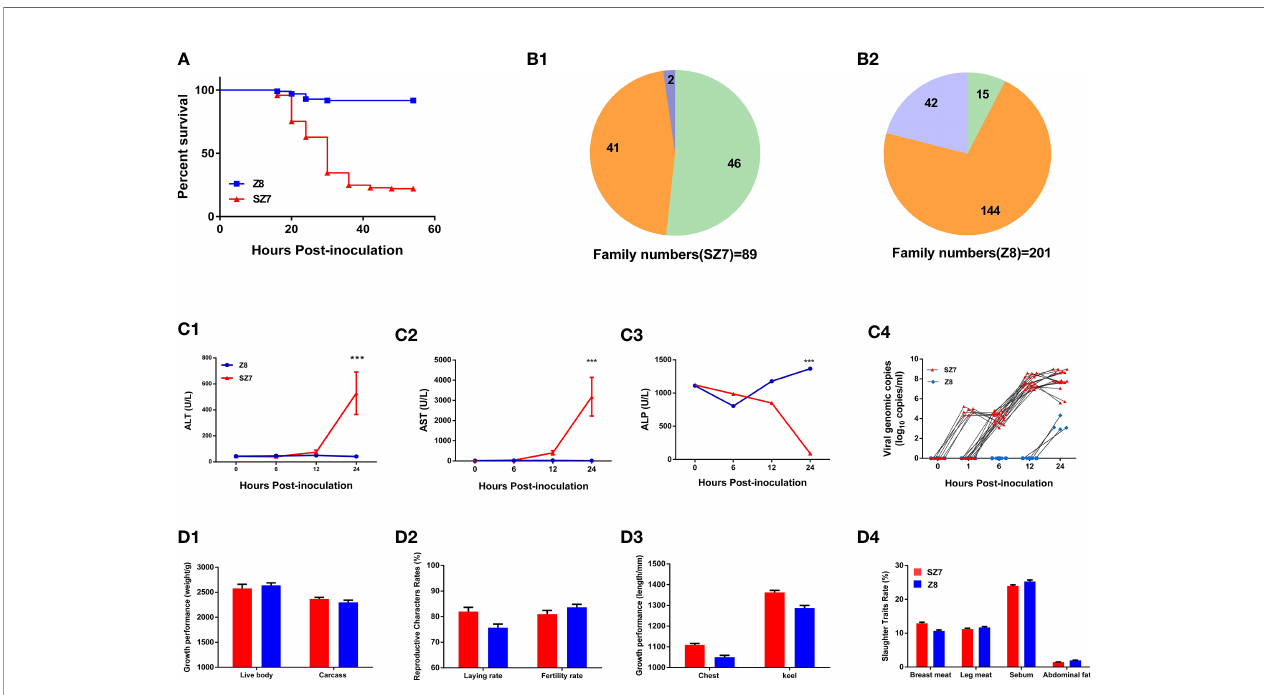
FIGURE 1 | Phenotypic differences between the Z8 and SZ7 fl ocks infected with DHAV-3. (A) Survival curves of populations Z8 and SZ7 used in this experiment. The fi gure shows the death curve for the intramuscular route of infection. (B1) Numbers of SZ7 families showing 100% survival, 100% mortality, 33.3% mortality, and 66.6% mortality. (B2) Numbers of Z8 families showing 100% survival, 100% mortality, and 11.1%-88.9% mortality. Orange represents the proportion of families with a mortality rate of 0%, green represents the proportion of families with a mortality rate of 100%, and blue represents the proportion of families with a mortality rate of >0 - <100%. (C) Blood ALT (C1) , AST (C2) , ALP (C3) and viral load levels (C4) in the population Z8 and SZ7 ducklings used in this experiment. The serum samples at each time point include 4 individual data points. The viral load at each time point includes 20 individual data points. *** P < 0.001. (D) The growth and reproductive performance of Z8 (n = 30) and SZ7 (n = 30), including live weight and carcass weight (D1) , egg-laying rate and hatching rate (D2) , chest width and keel length (D3) , rate of breast meat, leg meat, sebum and abdominal fat (D4)